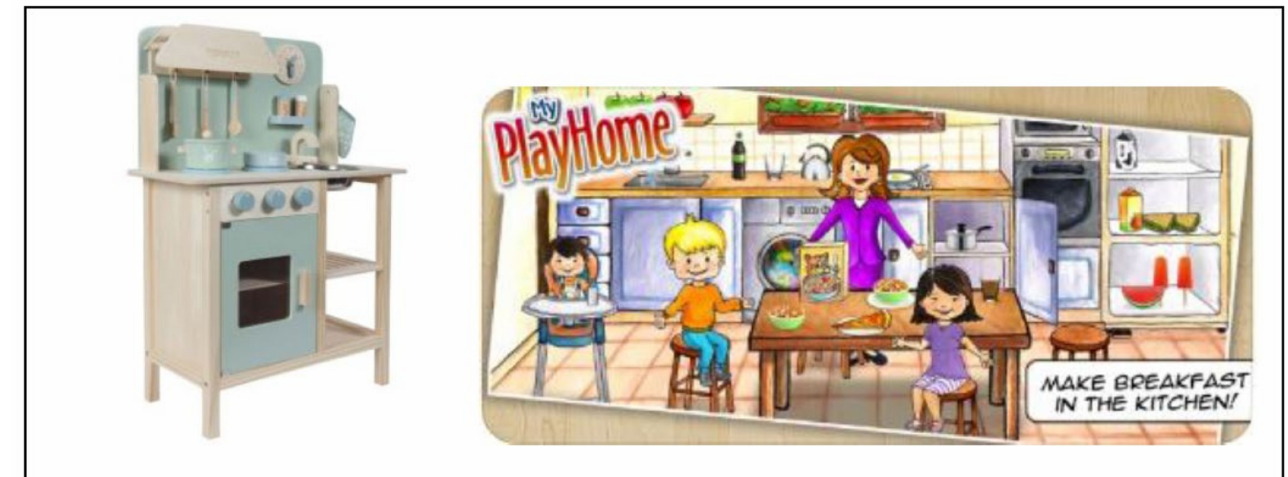
Figure 2. Play kitchen and screenshot of tablet game My PlayHome’s kitchen